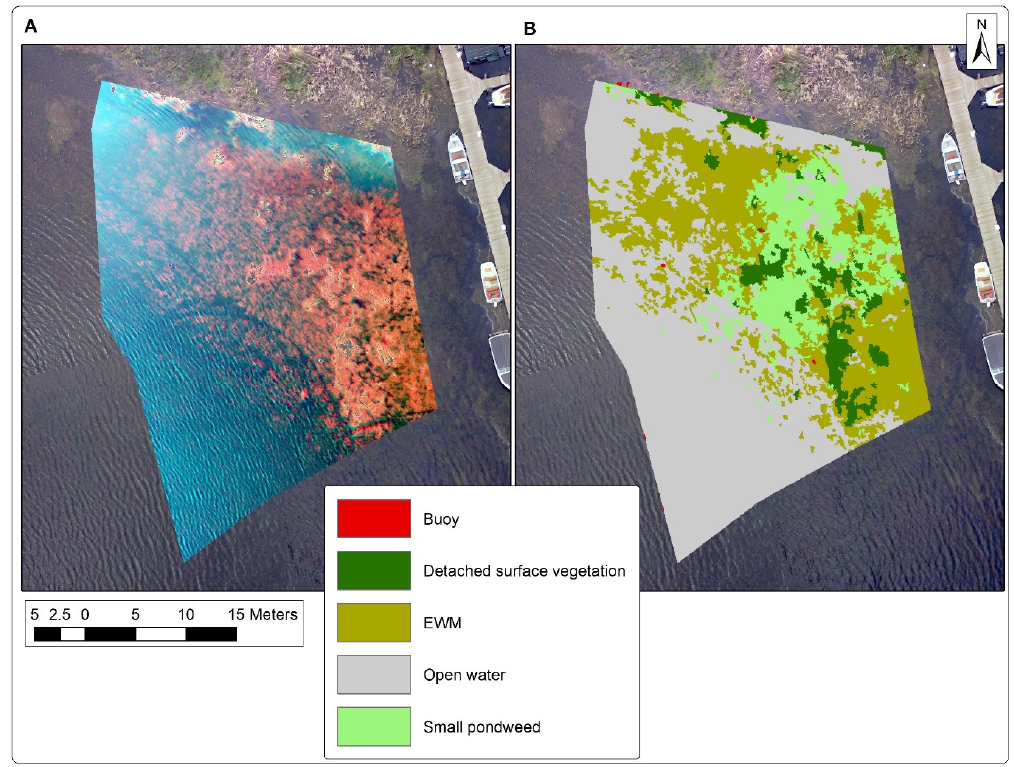
Figure 6. Court East June 2017 example result, with ( A ) VISNIR imagery and ( B ) classification result with scale parameter = 25.